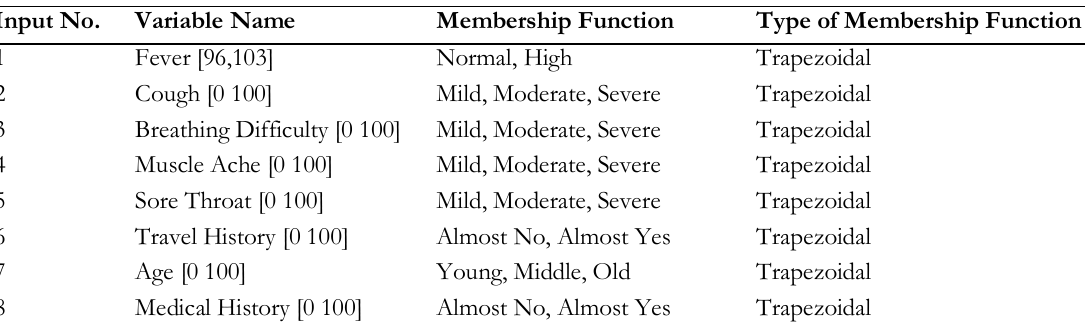
Table 1. Input variable and its membership